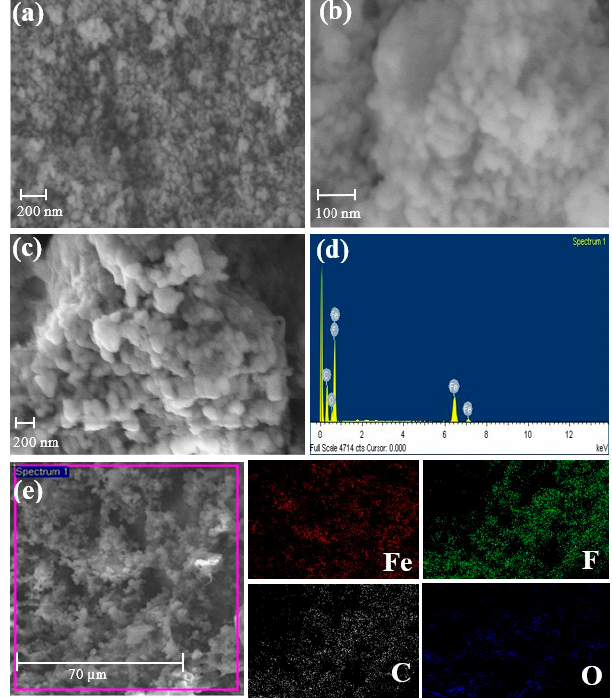
Figure 4. FESEM images of ( a and b ) C-Fe 3 O 4 nanoparticles, ( c ) C-Fe 3 O 4 /PVDF (M40), ( d ) EDS spectrum of M40, and ( e ) elemental mapping of M40.